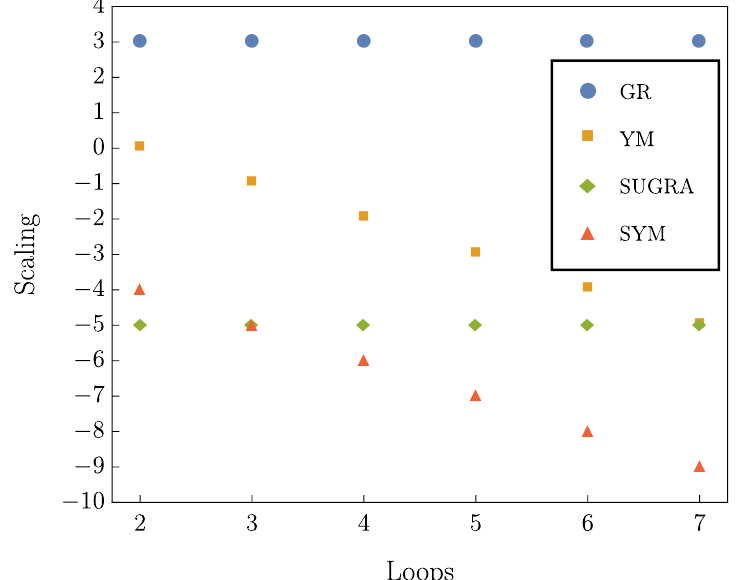
Figure 2: UV scaling of N = 8 SUGRA, (planar) N = 4 SYM, pure GR, and pure (planar)YM multi-particle unitarity cuts under four-dimensional deformations with results up to seven loops. The Scaling axis labels the leading t behavior of the cuts as t → ∞ . The thin lines denote the scaling in D-dimensions, where the continuous part has been checked explicitly and the dashed part is conjectured. There is an overall improvement of one power in the large t limit of gravity cuts with respect to D -dimensions; the same is not true for